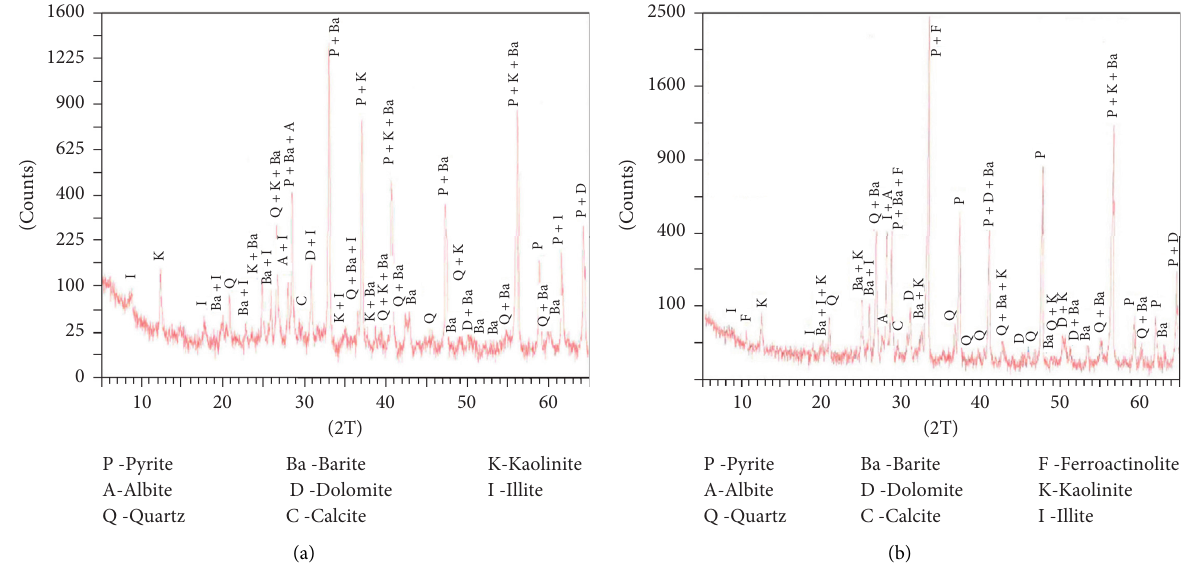
Figure 1: Mineralogical compositions of FT (a) and DT (b).